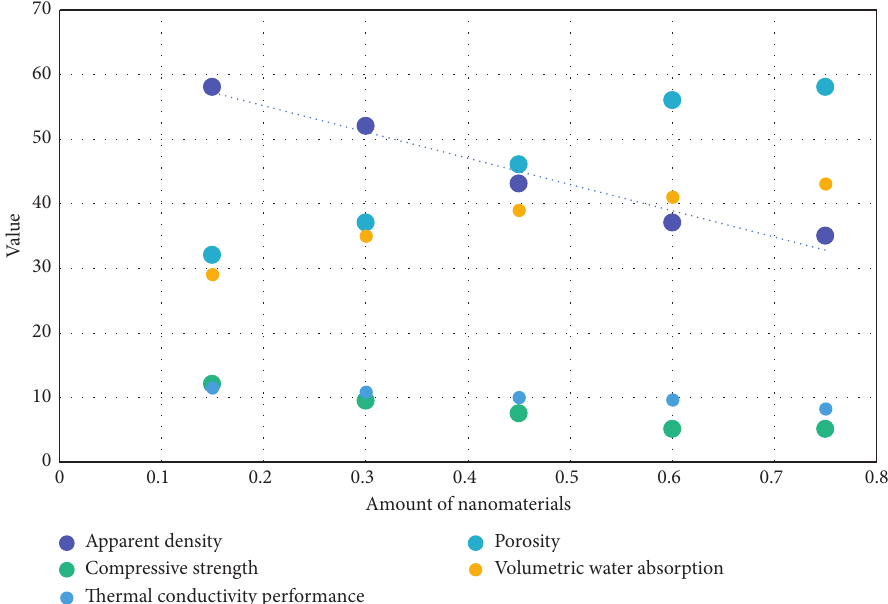
Figure 3: Result analysis diagram of nanometer material k12 parameter powder